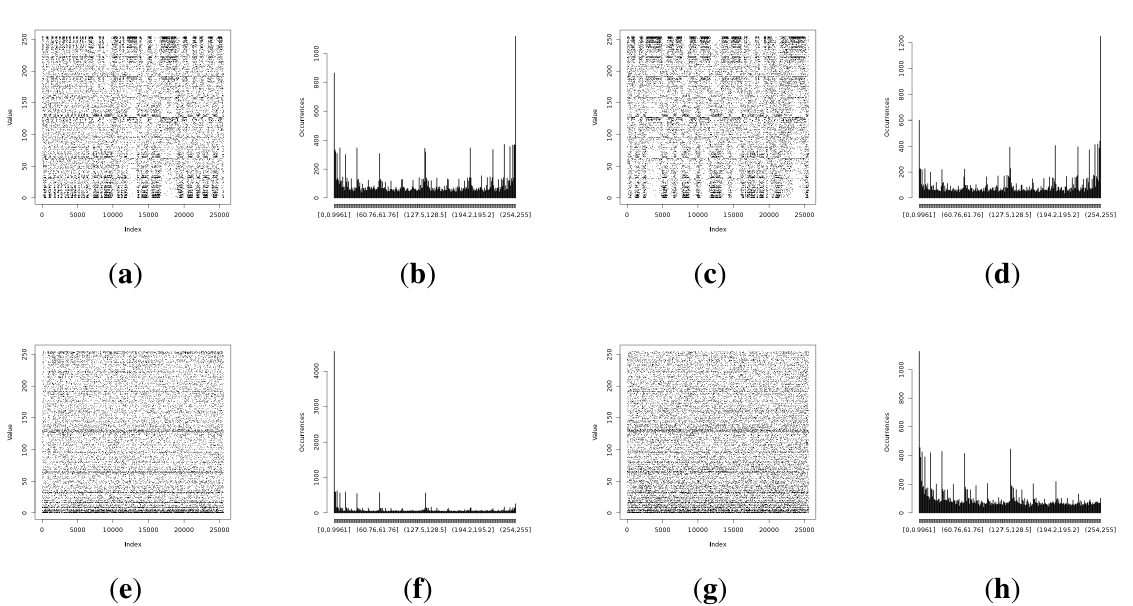
Figure 4. Initial experimental results of the harvested entropy by the first method in conjunction with the particular on-board sensor. ( a ) Light (1) sensor entropy; ( b ) distribution from the Light (1) sensor; ( c ) Light (2) sensor entropy; ( d ) distribution from the Light (2) sensor; ( e ) humidity sensor entropy; ( f ) distribution from the humidity sensor; ( g ) temperature sensor entropy; ( h ) distribution from the temperature sensor.